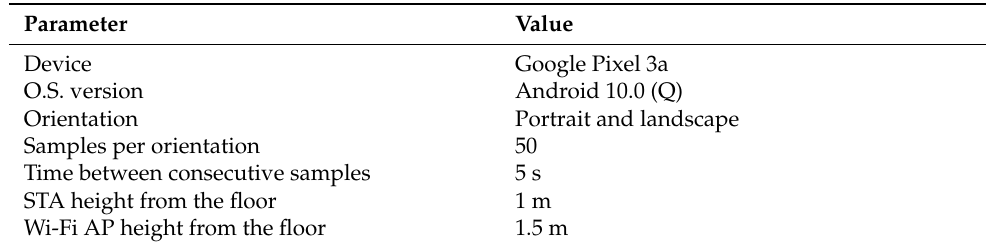
Table 3. Sampling parameters.